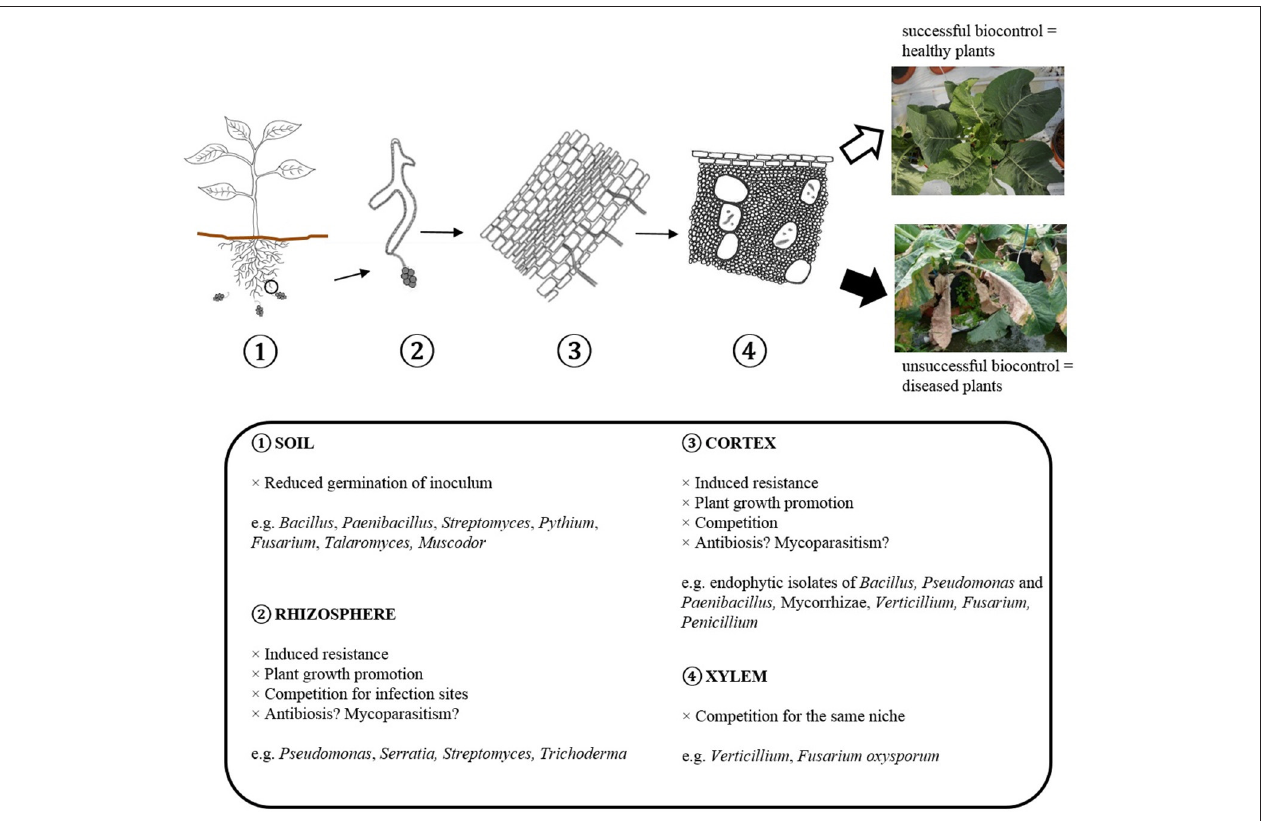
FIGURE 2 | Scheme showing how BCAs can interfere with different steps in the infection cycle of Verticillium